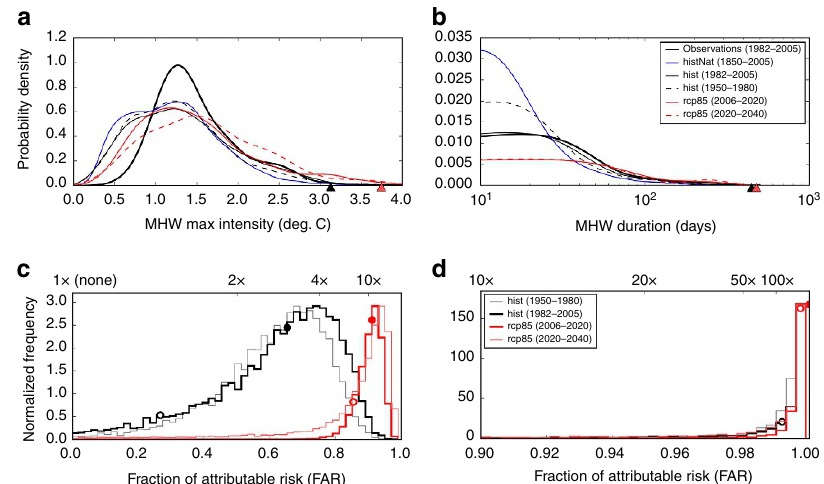
Figure 7 | Attribution of the 2015/16 Tasman Sea marine heatwave event using global climate models. The PDFs of the ( a ) maximum intensity and ( b ) duration of all MHWs detected from the observations (thick black line) and the ensemble of CMIP5 historical simulations over 1982–2005 (thin black line) and over 1950–1980 (dashed black line), historicalNat simulations (blue line), and RCP8.5 simulations over 2006–2020 (red line) and over 2020– 2040 (dashed red line), using a baseline climatology of 1881–1910. The black and red triangles indicate the properties of the event being attributed and of the 2015/16 event, respectively. The distribution of FAR values for a MHW of ( c ) maximum intensity 3.1 (cid:2) C or ( d ) duration of 446 days from the historical and RCP8.5 runs over four separate time periods. 1 (cid:2) (None) indicates no change in likelihood. The best estimate (median) and 10th percentile FAR values are indicated for the 1982–2005 and 2006–2020 periods by filled and open circles,